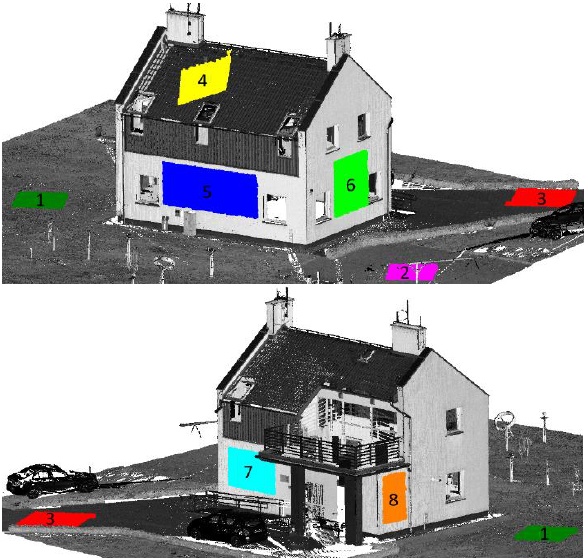
Figure 3. Location of 8 point cloud samples (color patches) used in accuracy evaluation, and reference TLS point cloud